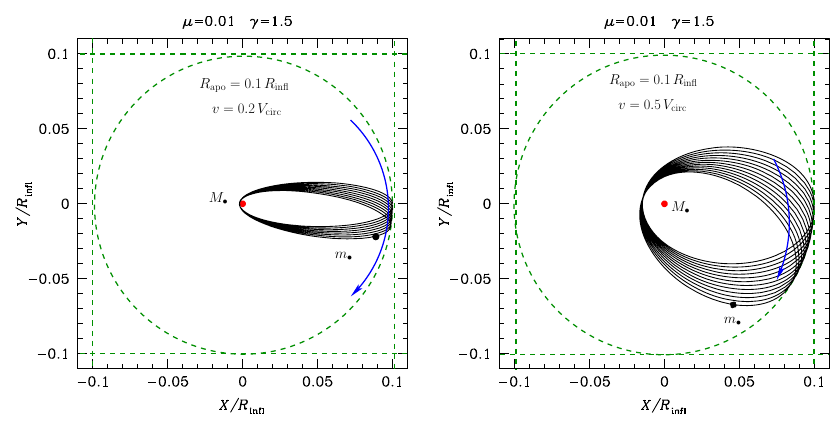
Fig. 10 Same as Figs. 8 and 9 for different values of the apoapsis radius and velocity of the CO